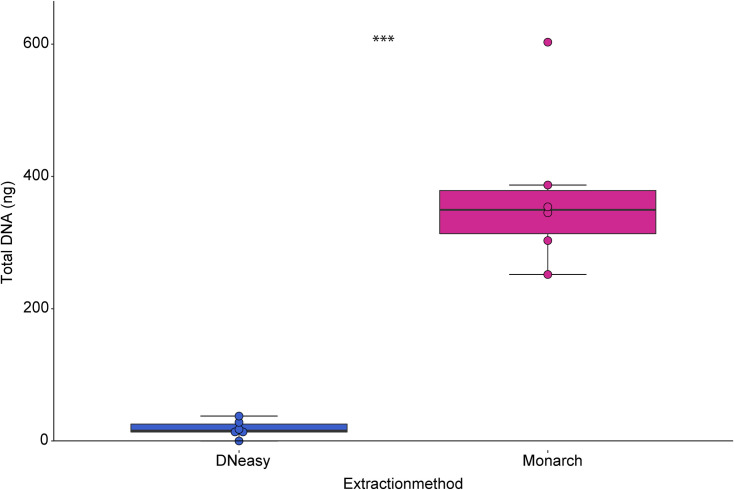
Comparison of total amounts of DNA extracted using the two protocols for the same individuals.The T-test was used to compare the means of the two protocols (*** p < 0.001).